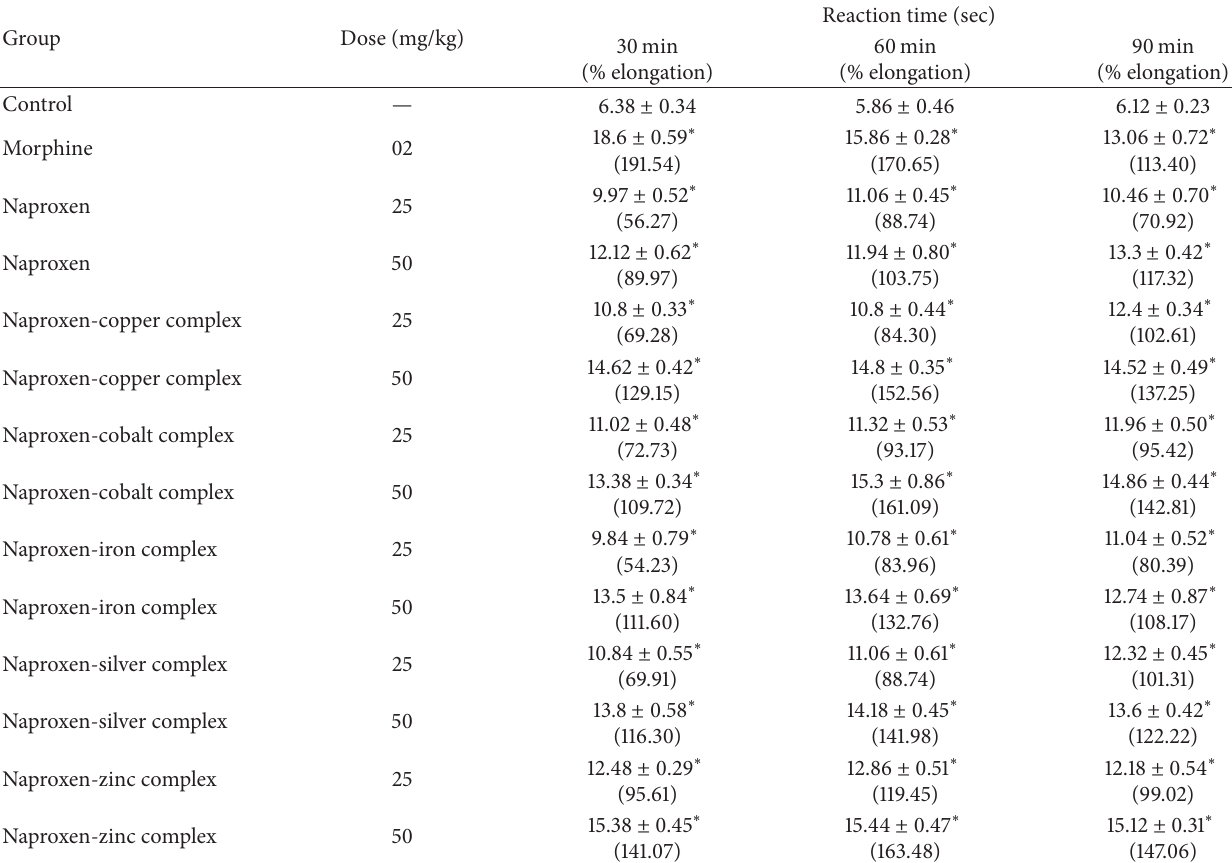
Table 2: Central antinociceptive activity of naproxen and its metal chelates at different time intervals.